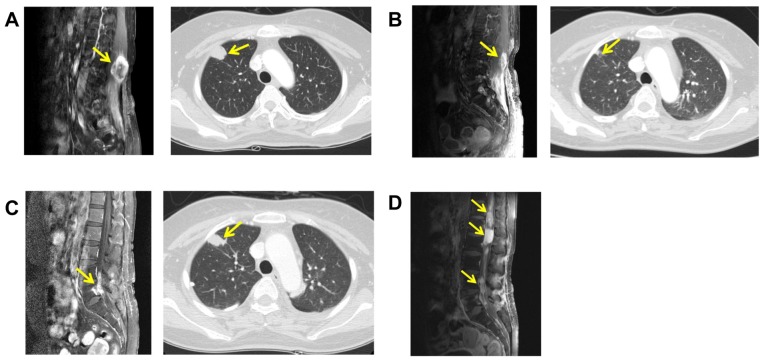
A 46-year old women with DFSP at paravertebral site at the level of L3–4 and RUL zone of chest.Lumbar spine MRI and chest CT were taken. A, before initiation of treatment with imatinib. B, after 4 months treatment with imatinib. C, after further 2 months treatment with imatinib and 3 months treatment with higher dose imatinib. D, at the time of disease progression with leptomeningeal metastasis.